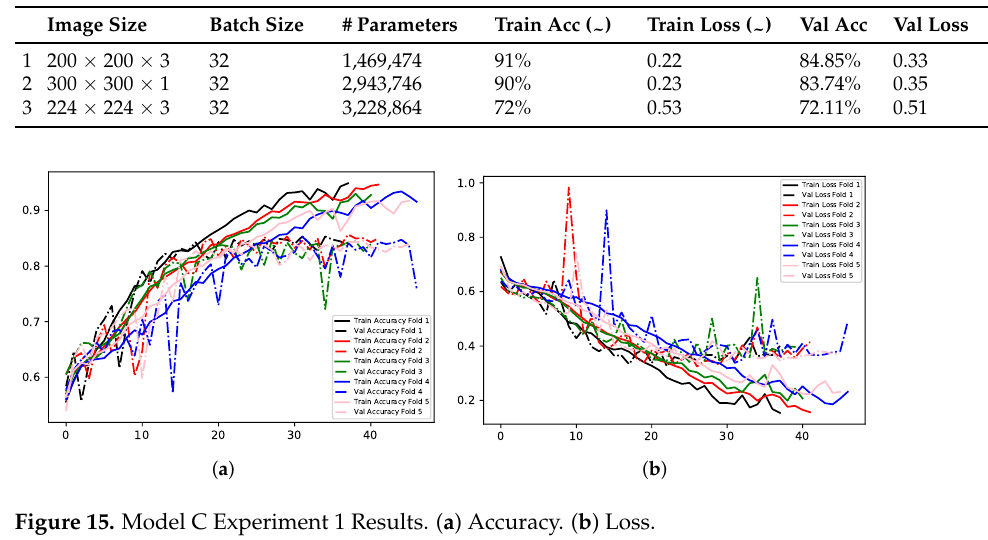
Table 6. Model C training and validation results.